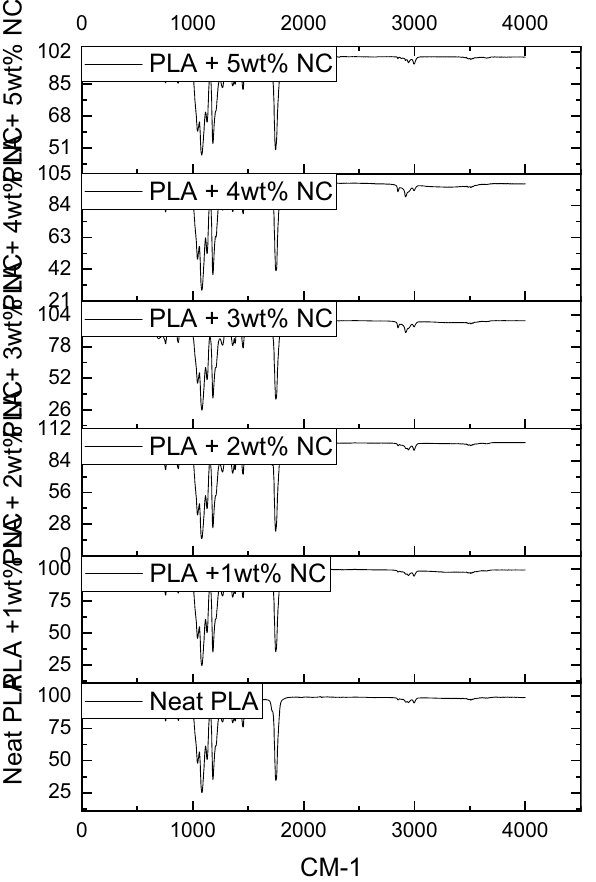
Figure 4. Fourier transforms infrared (FTIR) spectra of unfilled and nano-CaCO 3 reinforced polylactic acid bioplastic